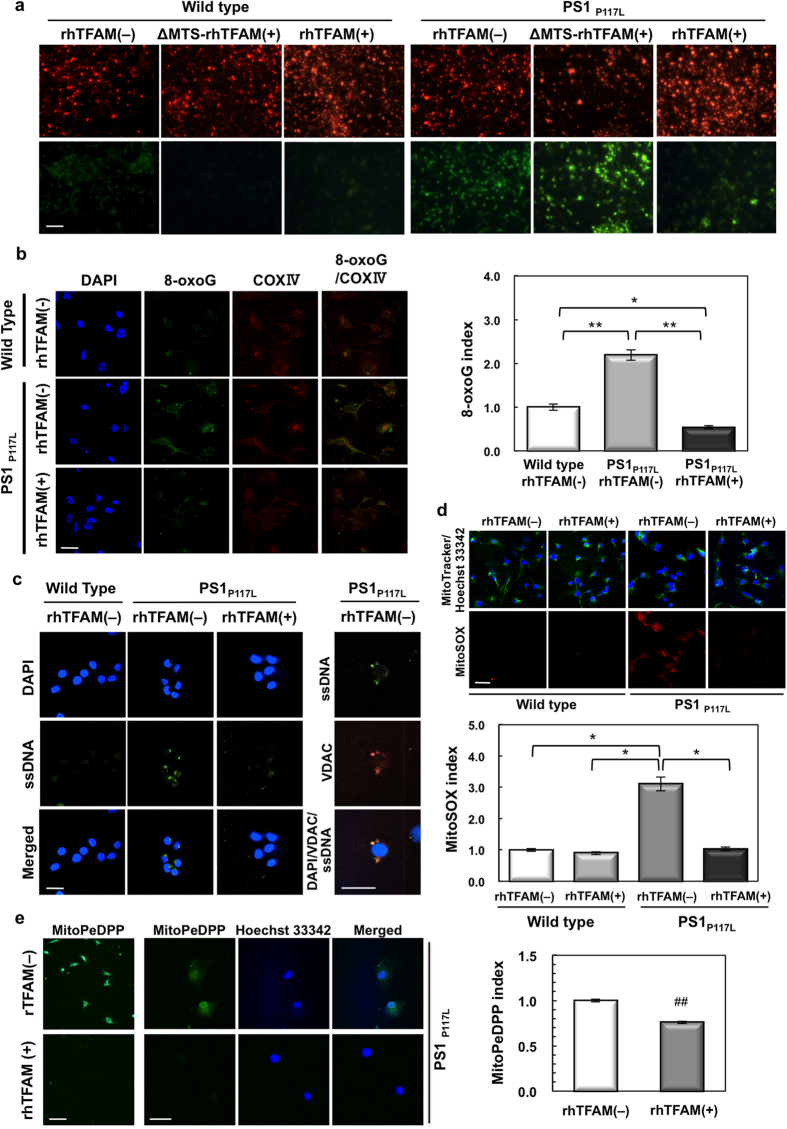
Recombinant human TFAM inhibits mitochondrial dysfunction and 8-oxoG accumulation in a human neuron model of AD.(a) Recombinant human TFAM [rhTFAM ( + )], but not mutant rhTFAM (ΔMTS-rhTFAM) lacking MTS, ameliorates mitochondrial dysfunction in PS1P117L cells. Mitochondrial membrane potential was detected using JC-1. Intensities of green fluorescence in ΔMTS-rhTFAM-treated PS1P117L neurons were as high as those seen in control PS1P117L neurons (rhTFAM[−]), whose levels were higher than those observed in wild-type neurons with or without rhTFAM or ΔMTS-rhTFAM. Upper panels: JC-1 aggregates with intense red fluorescence, indicating energized mitochondria with high membrane potentials. Lower panels: JC-1 monomers with green fluorescence, indicating damaged mitochondria with low membrane potentials. Scale bar, 100 μm. (b) rhTFAM decreases mitochondrial 8-oxoG in PS1P117L cells. COX IV was used as a mitochondrial marker. Fluorescence intensities of 8-oxoG in 50 cells were measured, and the 8-oxoG index is shown in the bar graph. One-way ANOVA, p < 0.0001. Tukey-Kramer HSD test, *p < 0.0026, **p < 0.0001. Data represent means ± SEM. (c) rhTFAM inhibits single-strand breaks in mitochondrial DNA in PS1P117L cells. VDAC was used as a mitochondrial marker. (d) rhTFAM decreases mitochondrial superoxide production in PS1P117L cells. Wild-type and PS1P117L cells were treated with or without rhTFAM for 24 h, and then incubated with MitoTracker Green, a mitochondrial marker (upper panels, green) and MitoSOX, a mitochondrial superoxide indicator (lower panels, red). Nuclei were counterstained with Hoechst 33342 (upper panels, blue). Fluorescence intensities of MitoSOX in 50 cells were measured, and the MitoSOX index is shown as a bar graph. Two-way ANOVA, p < 0.0001. Tukey’s HSD test, *p < 0.0001. Data represent means ± SEM. (e) rhTFAM protein suppresses mitochondrial membrane lipid peroxidation in PS1P117L cells. MitoPeDPP, a fluorescent probe specific for lipophilic peroxide in the mitochondrial inner membrane was applied to PS1P117L cells with or without rhTFAM treatment. Nuclei were counterstained with Hoechst 33342. Fluorescence intensities of MitoPeDPP in 50 cells were measured, and the MitoPeDPP index is shown as a bar graph. Student’s t-test: ##p < 0.0001. Data represent means ± SEM. Scale bars, 40 μm (b–e).